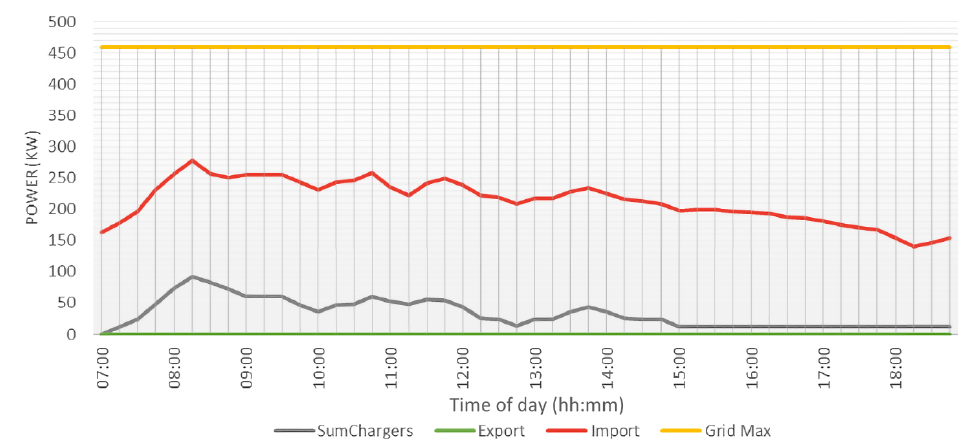
Figure 17. Charging patterns of one day of charging at Royal Reesink BV in Apeldoorn. Shown are the import from (red) and export to (green) the grid, as well as the contracted maximum (yellow) and power demand of all EVSE combined